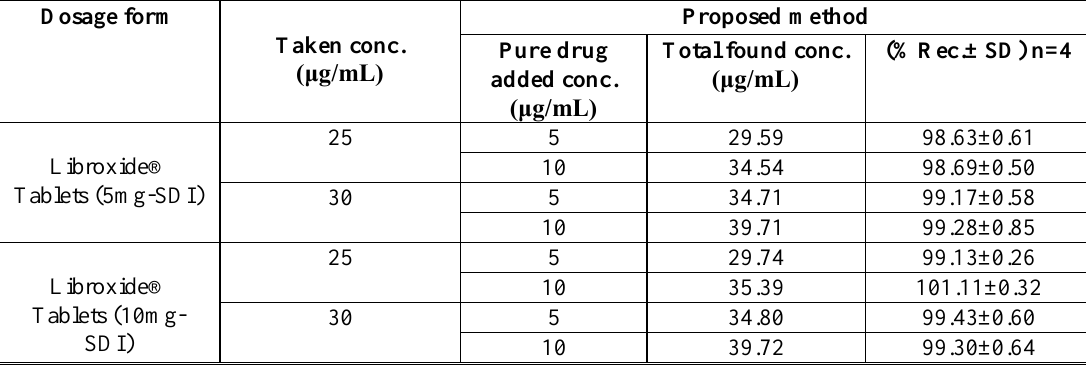
Table 6. Comparison and application of the current and UV methods.